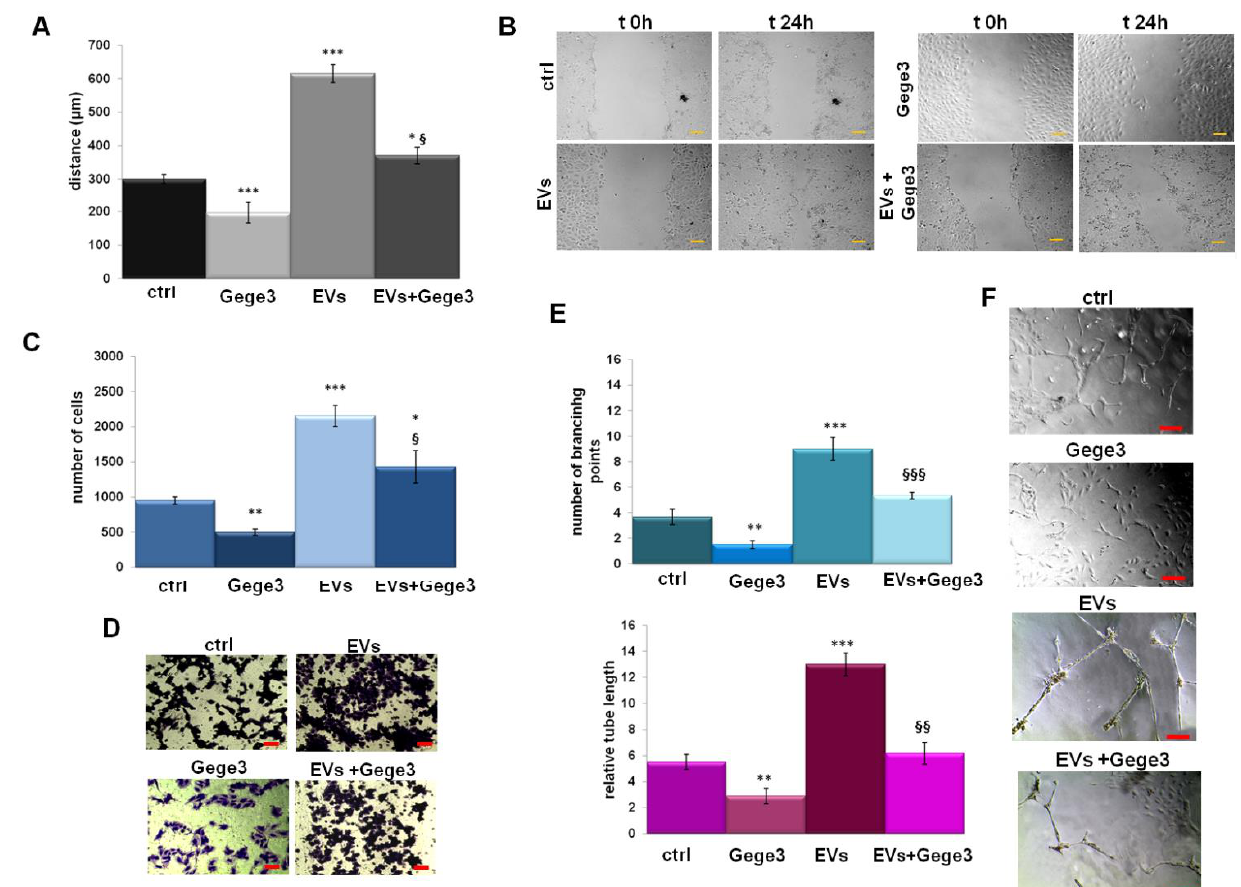
Figure 4. The influence of Gege3 on EV activity. ( A ) Migration, ( C ) invasion speed, and ( E ) in vitro angiogenesis of HUVEC cells treated with EVs secreted from MIA PaCa-2 cells in the presence or not of Gege3 10 µM. Representative bright-field images are reported for wound healing assay ( B ), for invasion one ( D ) and angiogenesis ( F ). The bars of each bright-field image are 50 μm . Data represent the mean of three independent experiments ± standard deviation with similar results. * p < 0.05; ** p < 0.01; *** p < 0.001 for treated cells vs. untreated controls; § p < 0.05; §§ p < 0.01; §§§ p < 0.001 for the point with EVs + Gege3 vs. EVs.